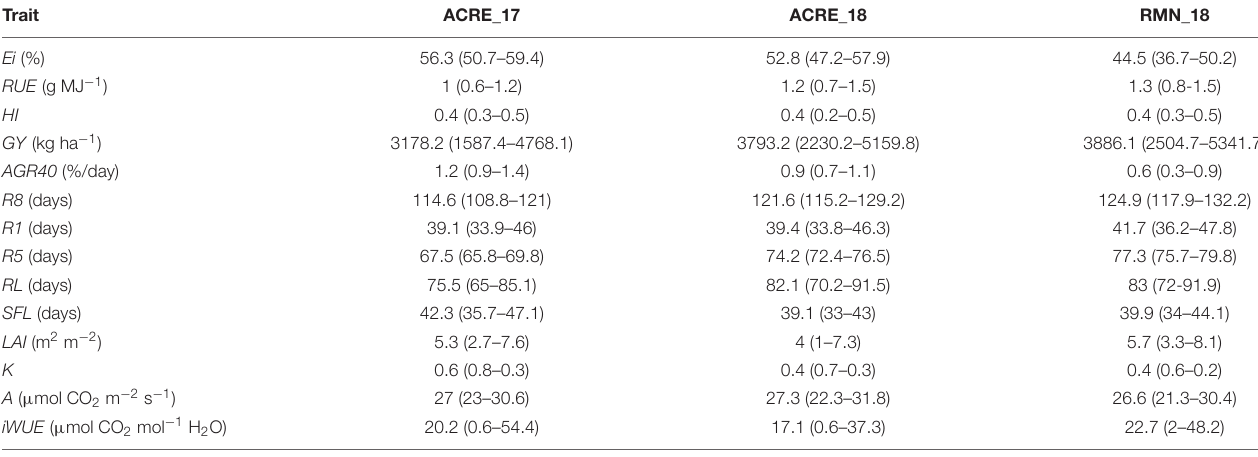
TABLE 3 | Descriptive statistic for the evaluated phenological and physiological traits. Trait